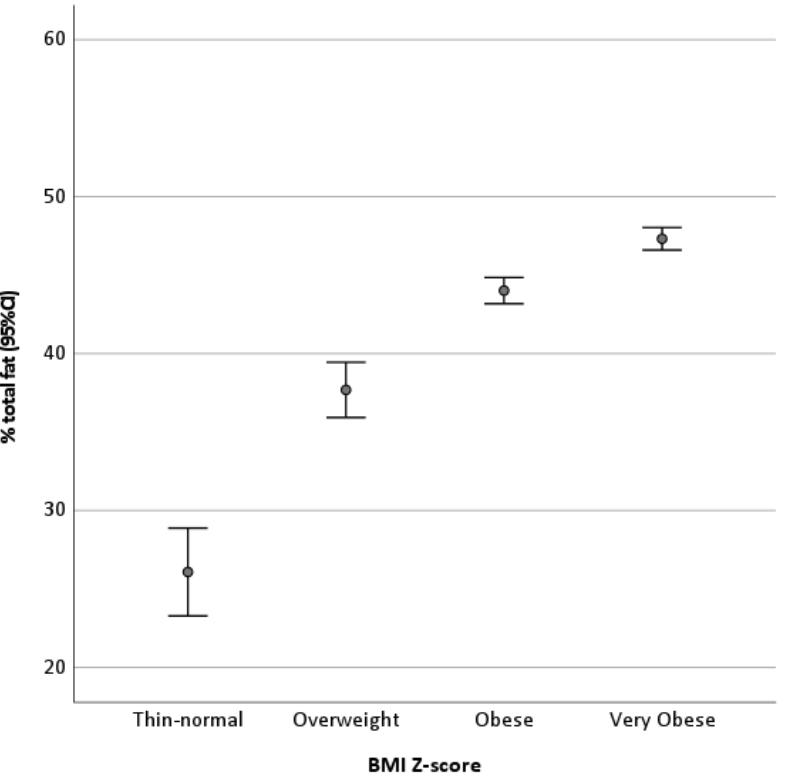
Figure 1. Percentage of body fat (mean ± 95%CI) according to nutritional status classification by BMI Z-score.